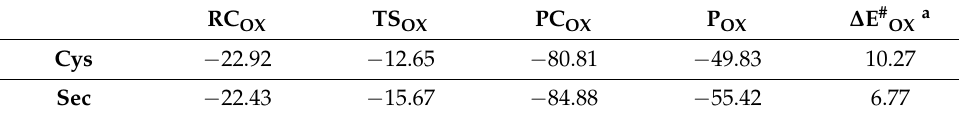
Table 4. Electronic energies (kcal mol − 1 ) relative to free reactants for the oxidation of free amino acids (Scheme 12) along the SAPE pathway. Level of theory: ZORA-BLYP-D3(BJ)/TZ2P. a Data taken from